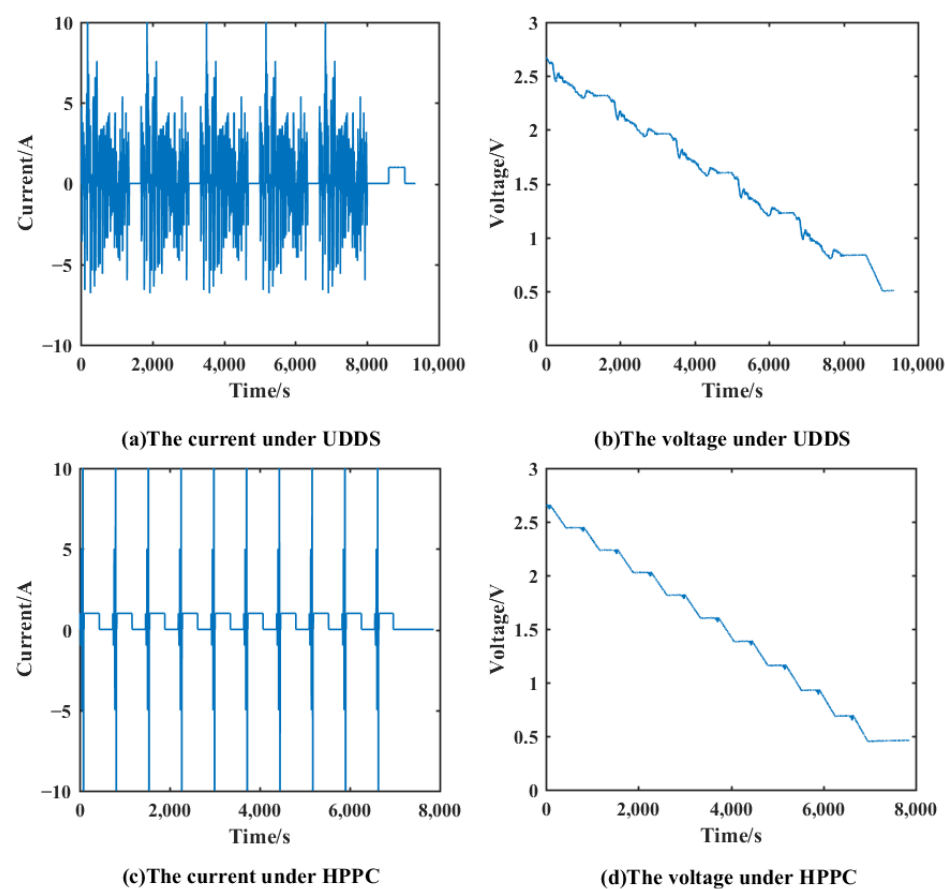
Figure 1. HPPC current and voltage diagram and UDDS current and voltage diagram. ( a ) Current under UDDS. ( b ) Voltage under UDDS. ( c ) Current under HPPC. ( d ) Voltage under UDDS.